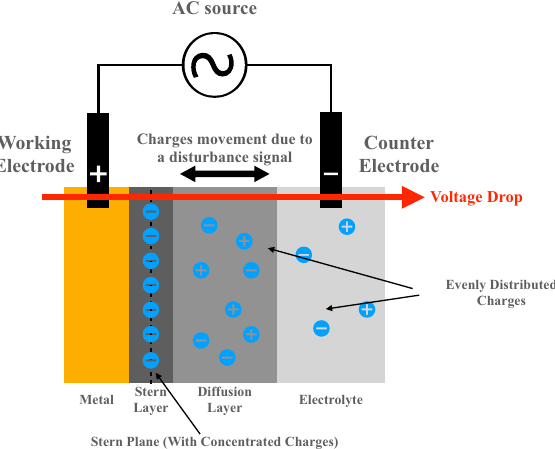
Figure 1. Charging and discharging of the double layer caused by the AC